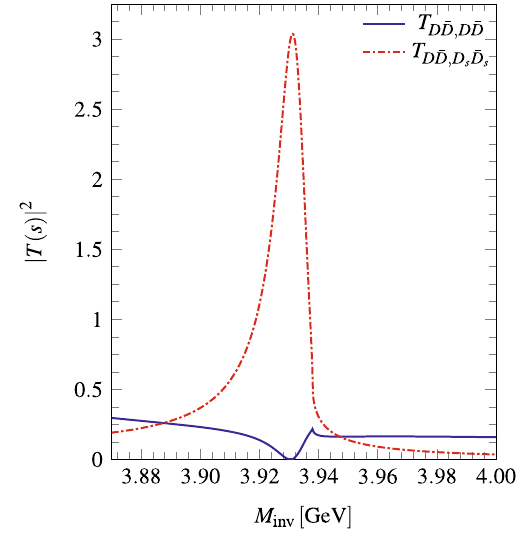
Fig. 7 Squaredmodulusofthetransitionmatrixelements T T appearing in ˜ t J /ψ ω in Eq. (8) Fig. 8 Differentialdecayforthereaction B D + s D − s , D ¯ D